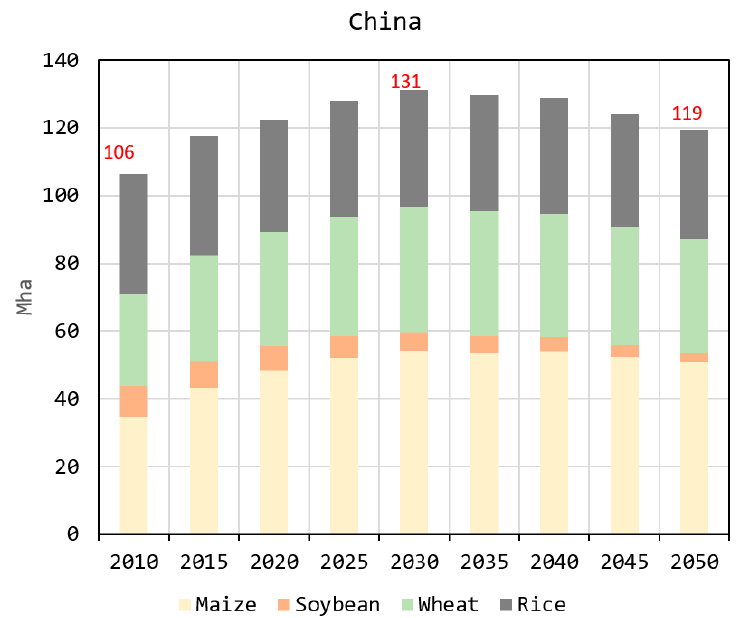
Figure 9. Land use projections by crop in the reference scenario.